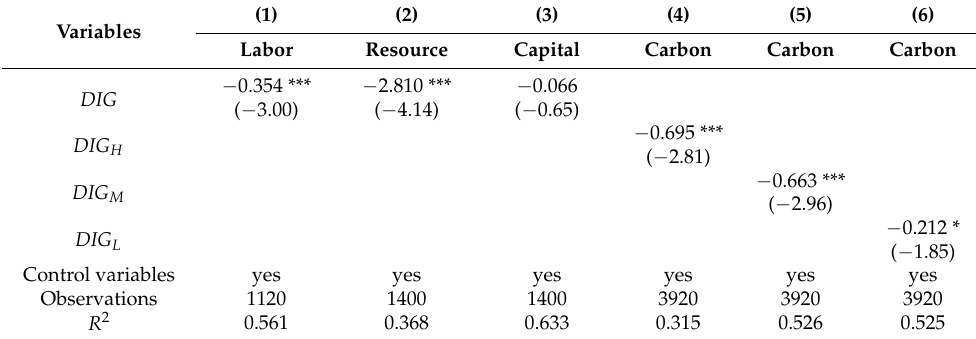
Table 6. Heterogeneity